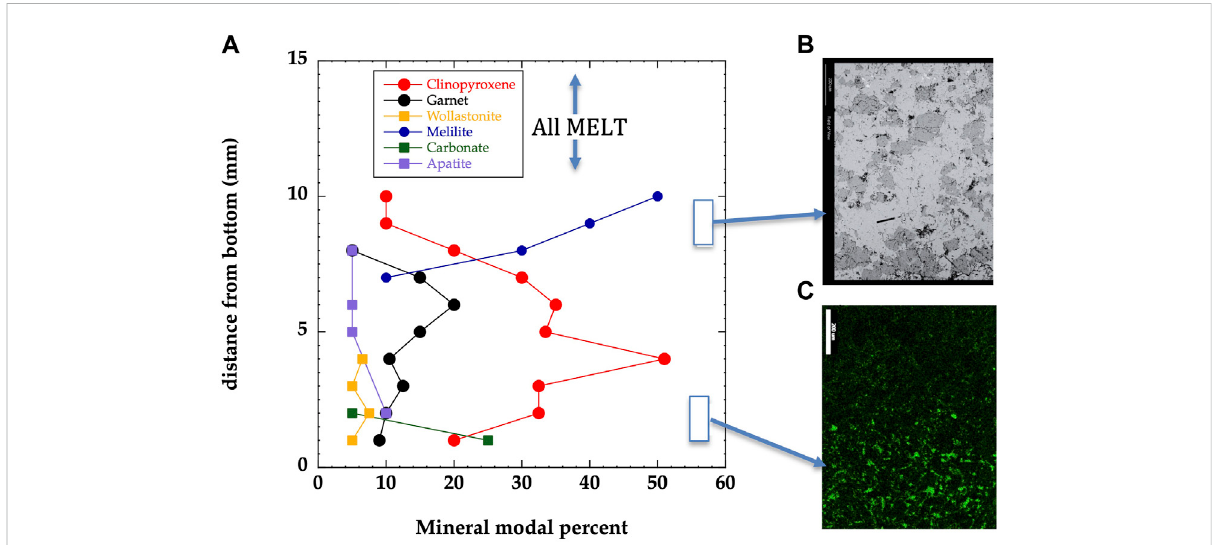
FIGURE 4 (A) ODL-5wk is modally layered as a function of temperature (position) for the Ca-rich phases: melilite mode decreases from 10 to 7 mm, the garnet mode peaks at 7 mm, the clinopyroxene mode peaks at 4 mm and fi nally, wollastonite is found in the bottom 3 mm. Nepheline is found throughout. (B) BSE image shows complete lack of melt within the crystalline assemblage just below the melt-interface (upper rectangle in A) in ODL-5wk. (C) X-ray map of phosphorous showing dramatic increase in apatite mode near bottom (lower rectangle in